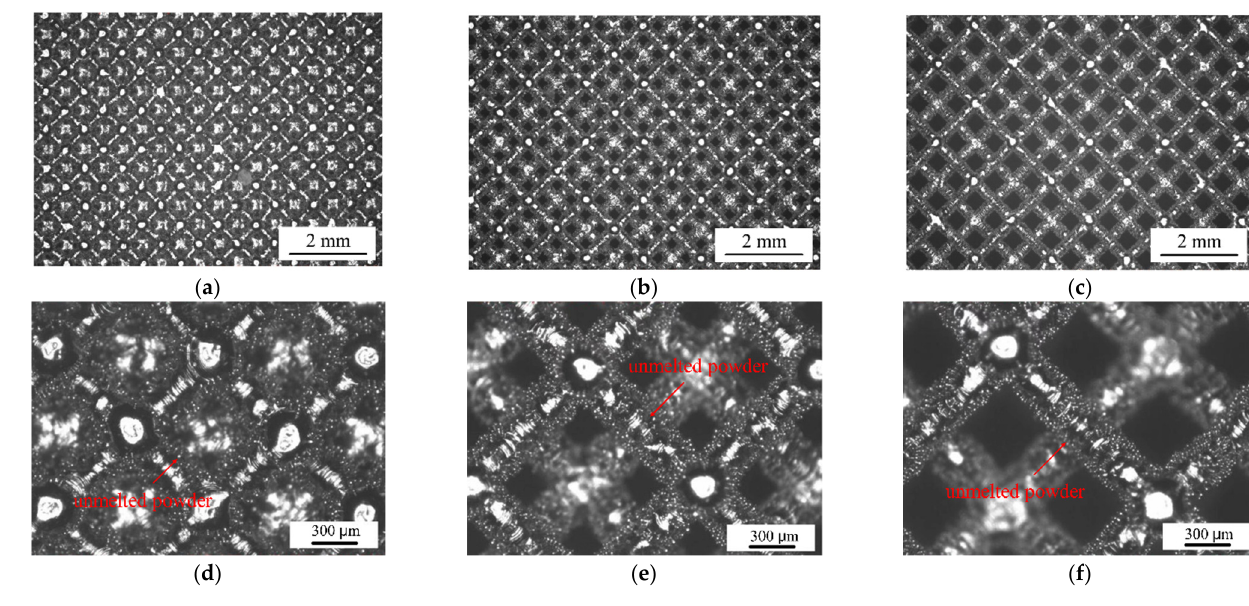
Figure 7. Morphology of the struts and pores of SLM porous Ti6Al4V specimens: ( a ) cell size 1 mm; ( b ) cell size 1.5 mm; ( c ) cell size 2 mm; ( d ) cell size 1 mm; ( e ) cell size 1.5 mm; ( f ) cell size 2 mm.